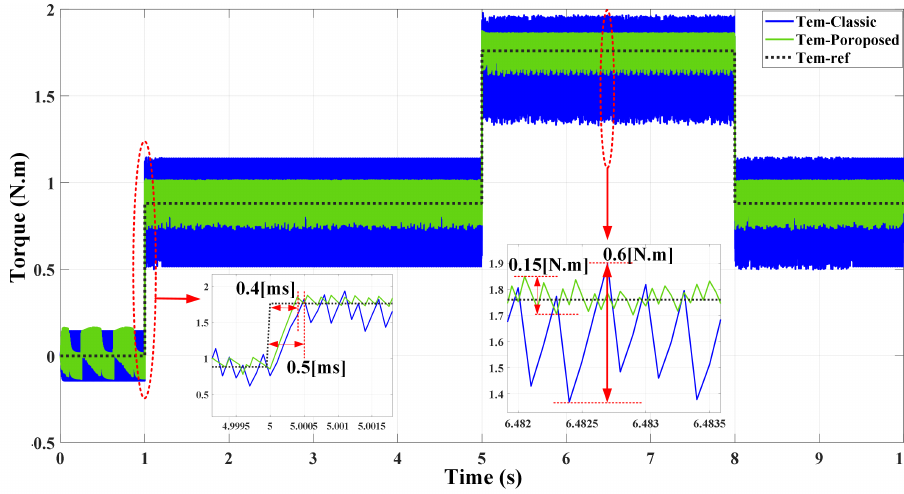
Figure 12. The torque responses in both the classical and improved